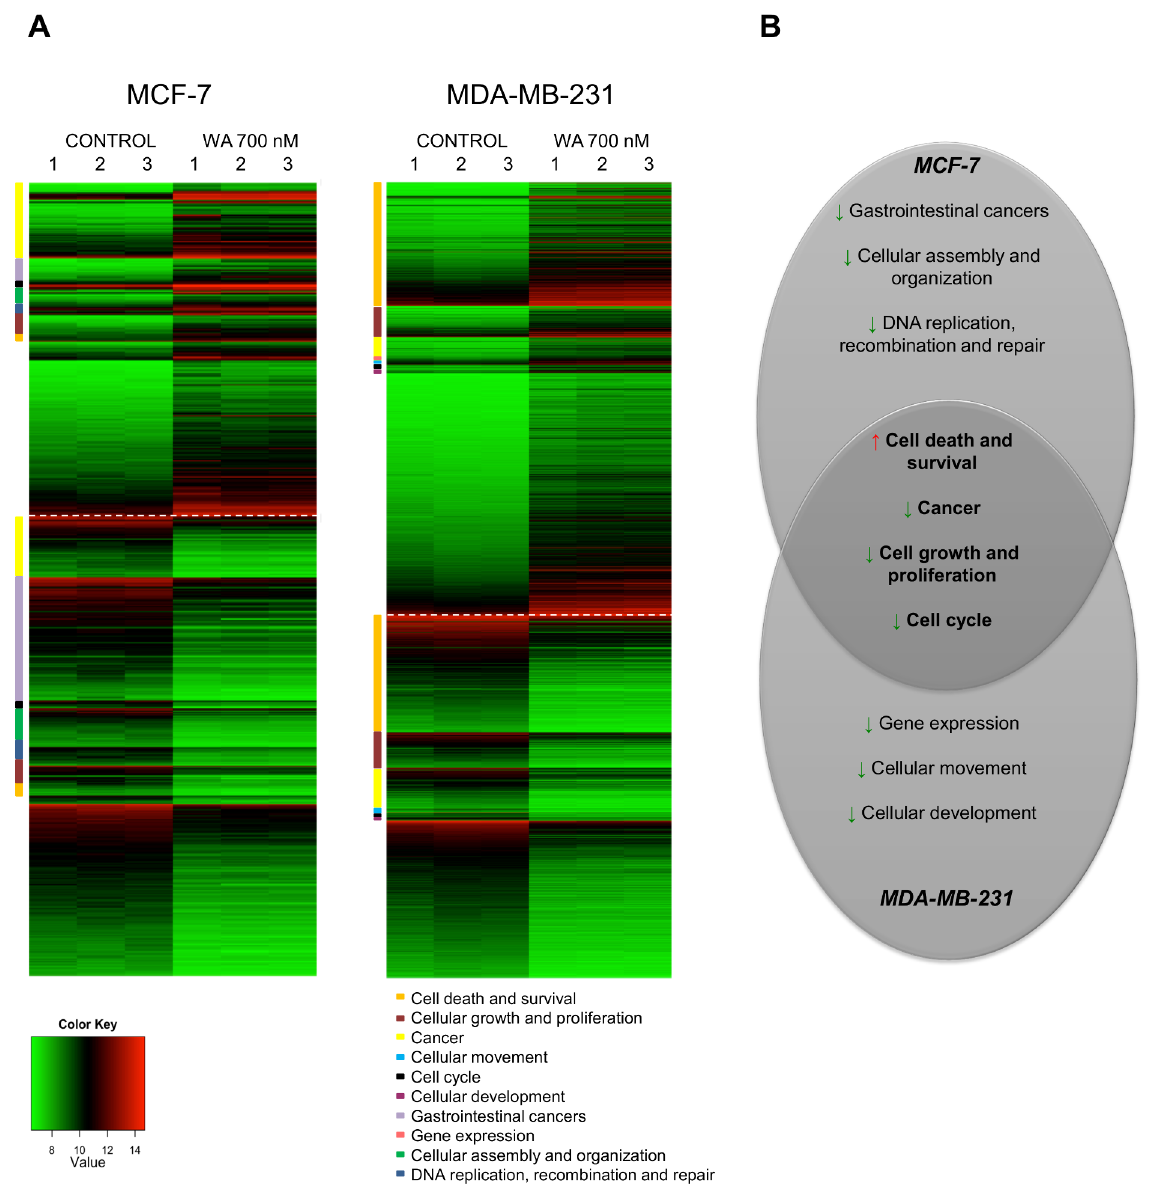
Figure 2. Biological processes affected by WA treatment in MDA-MB-231 and MCF-7 cells. (A) The heatmap represents gene expressions for control and WA 700 nM treated MDA-MB-231 and MCF-7 cells. Only genes that have a log 2 fold change (FC) $ 1 or # 1 between control and WA- treated samples and have a p-value , 0.001 are plotted. Genes that are upregulated in treated samples are plotted above the dashed line (FC $ 1), those that are downregulated in treated samples are plotted below (FC # 1). Genes that belong to a specific IPA biological process are clustered and represented by a colored square next to the heatmap. Color key legend represents log 2 normalized expression values ranging from green (low expression) to red (high expression). (B) Venn diagram represents common and cell line-specific IPA biological processes with predicted activation state (Red arrow represents increase of a biological process- Activation Z-score $ 2; Green arrow represents decrease of a biological process- Activation Z-score # -2). dependent repression of Fra-1 ( FOSL1 ) transcription factor, is in line with our previous results [16] and the known role of Fra1 in cell proliferation, motility and invasiveness of breast cancer cell lines [23,24]. This further supports the hypothesis that effective- ness of WA in triple negative breast cancer is mediated by inhibition of cell motility and invasion programs.